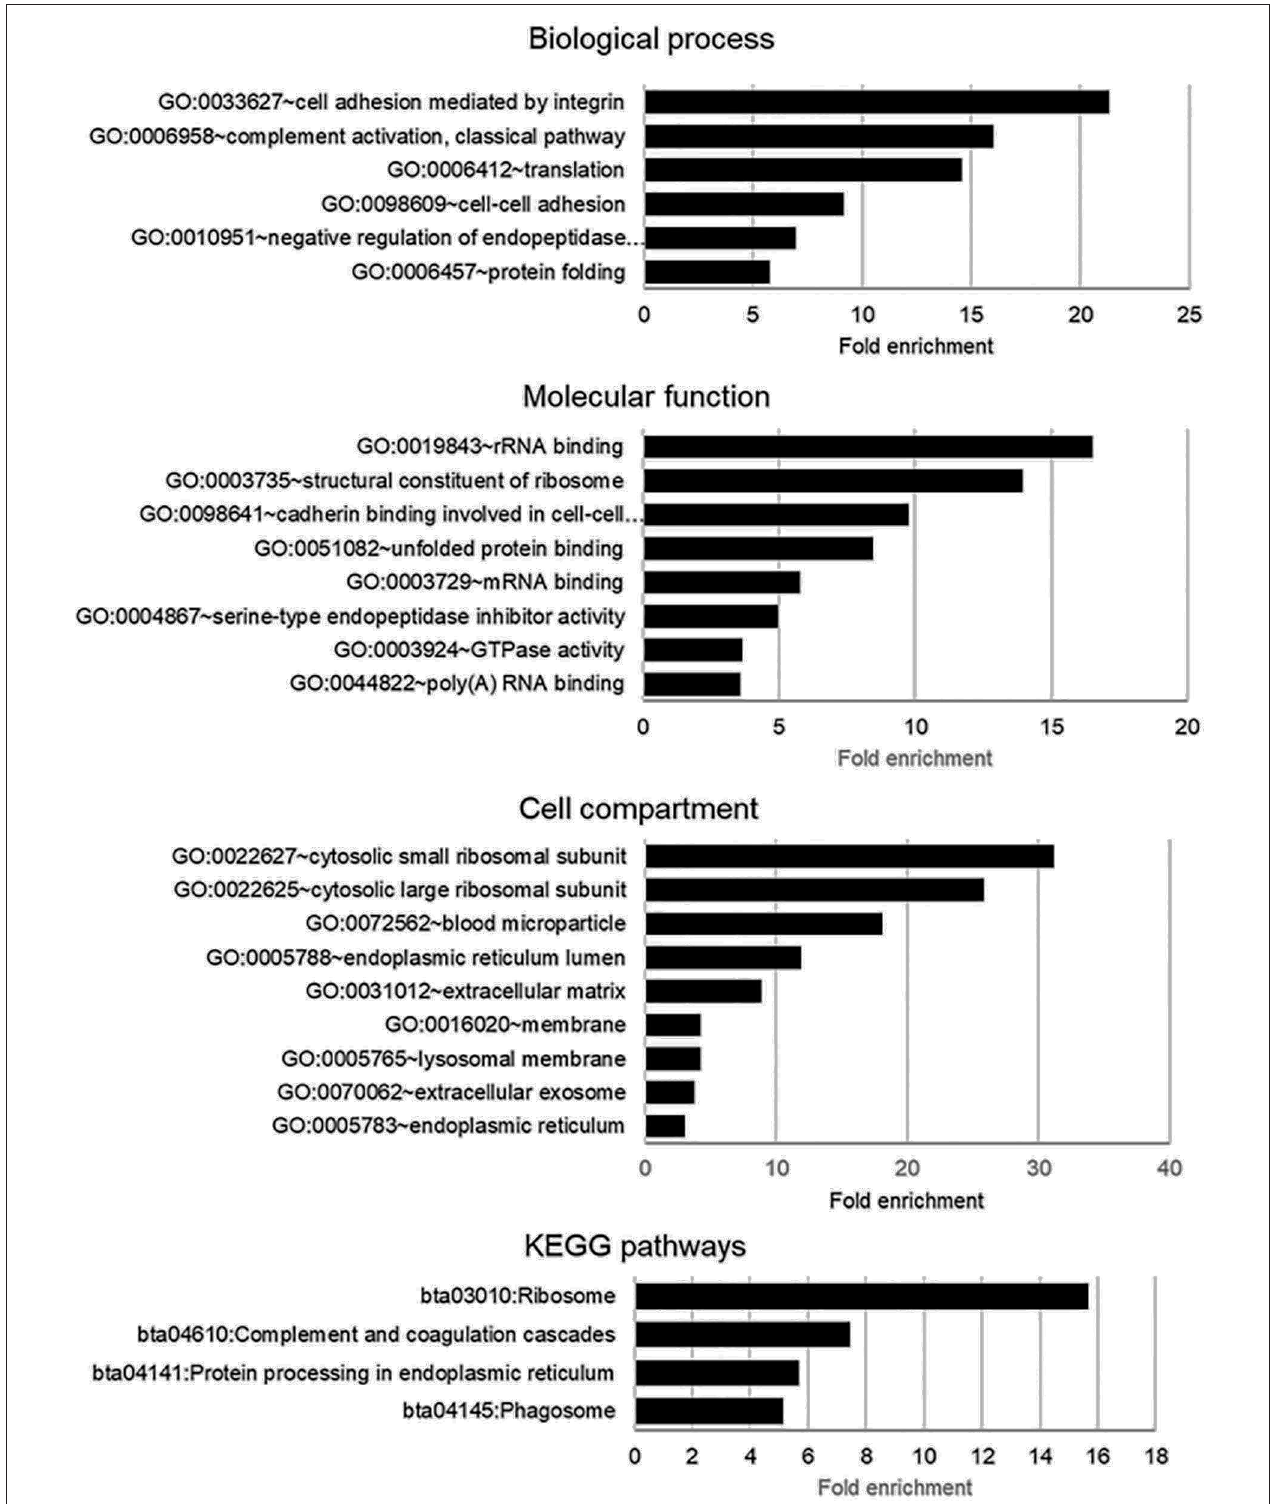
FIGURE 4 | Gene Ontology (GO) enrichment biological processes, molecular functions, and biological pathway terms in genes encoding the proteins identified from exosome-like extracellular vesicles derived from bovine follicular fluid (ffEVs). The analysis was performed using the DAVID 6.8 application (https://david.ncifcrf.gov/ home.jsp). Only significantly enriched GO terms are shown (Benjamini–Hochberg corrected values of p < 0.05 were considered significant).